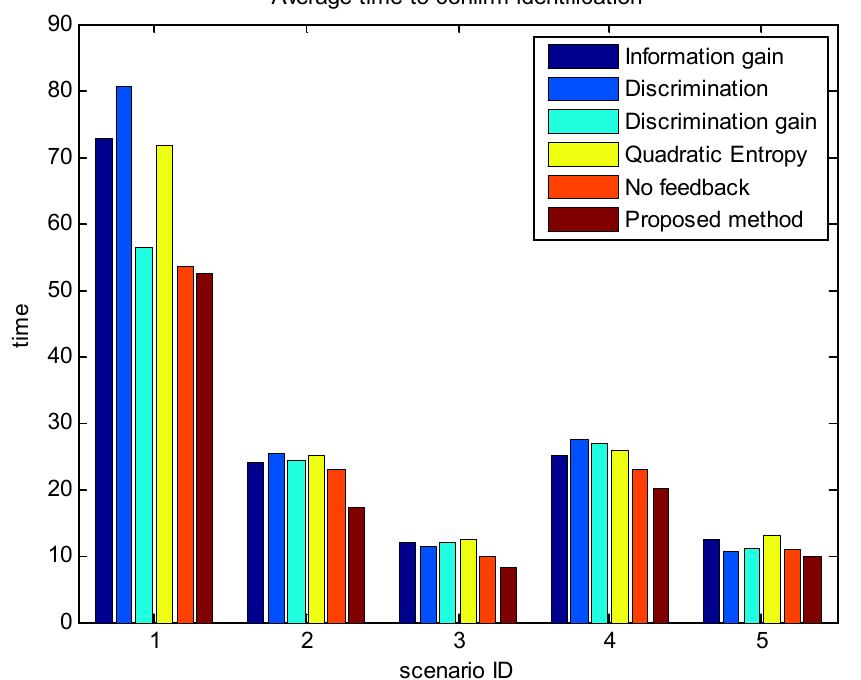
Figure 14. Comparison chart of average confirmation recognition time based on various algorithms under condition 4.